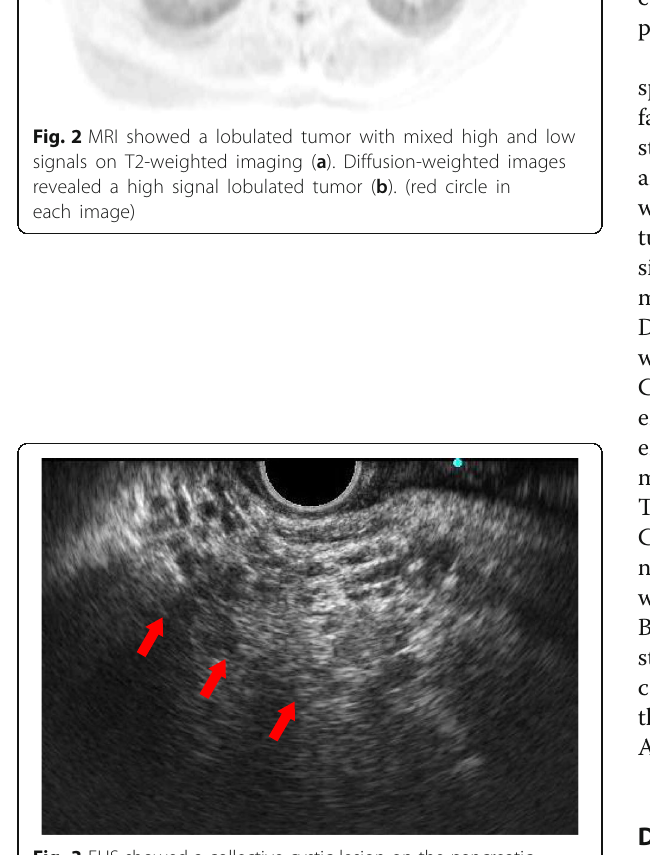
Fig. 3 EUS showed a collective cystic lesion on the pancreatic uncinate process (red